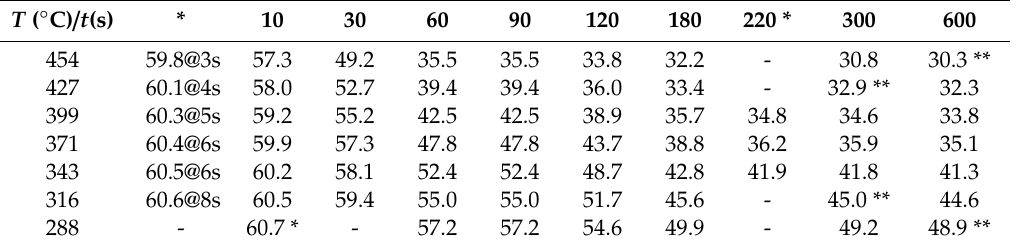
Table 3. 4140 steel hardness HRC achieved with measured and estimated bainite transformation start and finish